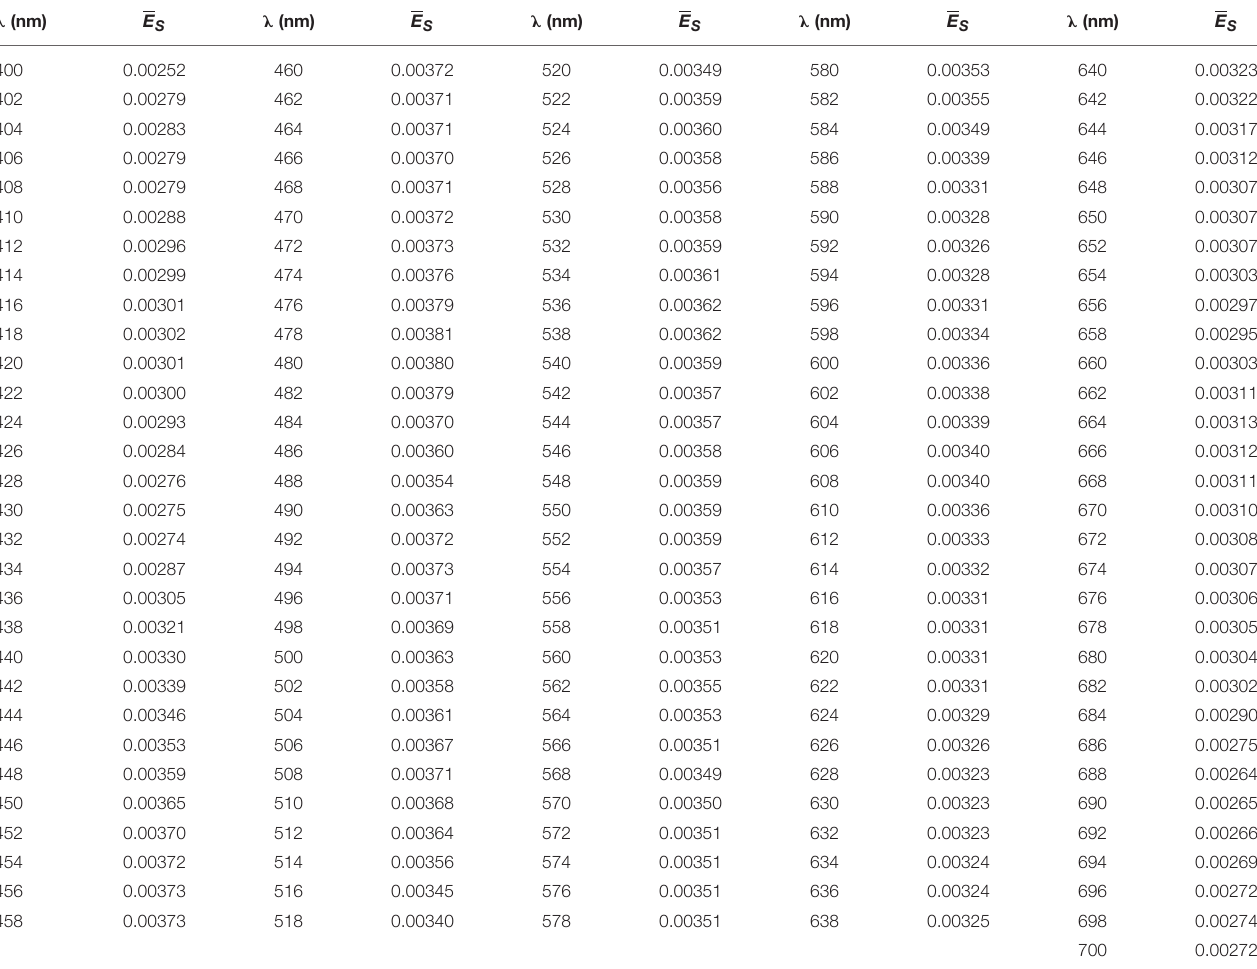
TABLE A1 | Normalized spectra [ E S ( λ ), dimensionless] for the visible spectra (400–700